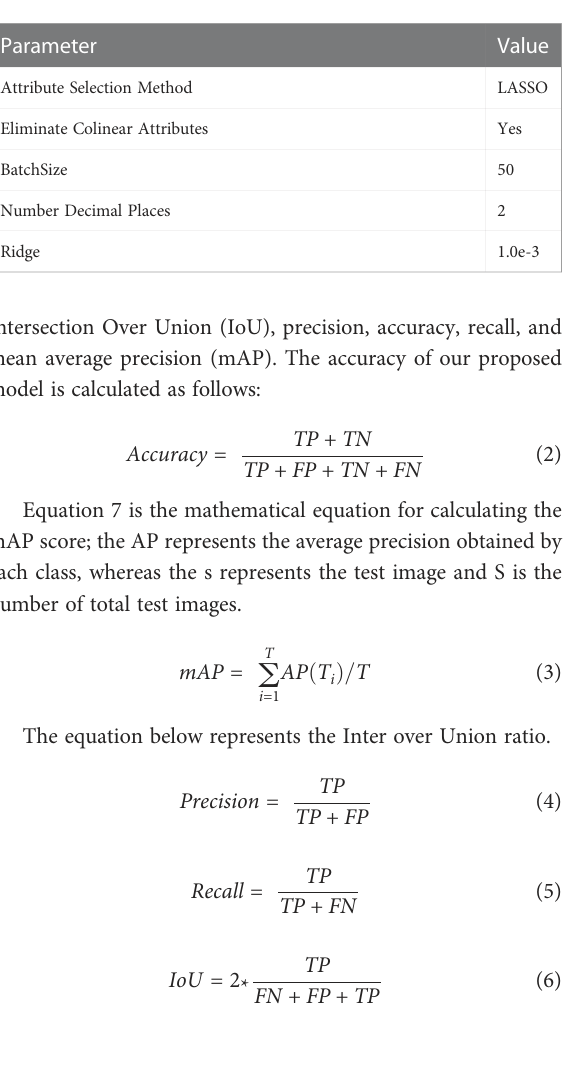
TABLE 5 List of parameters used for the training of linear regression